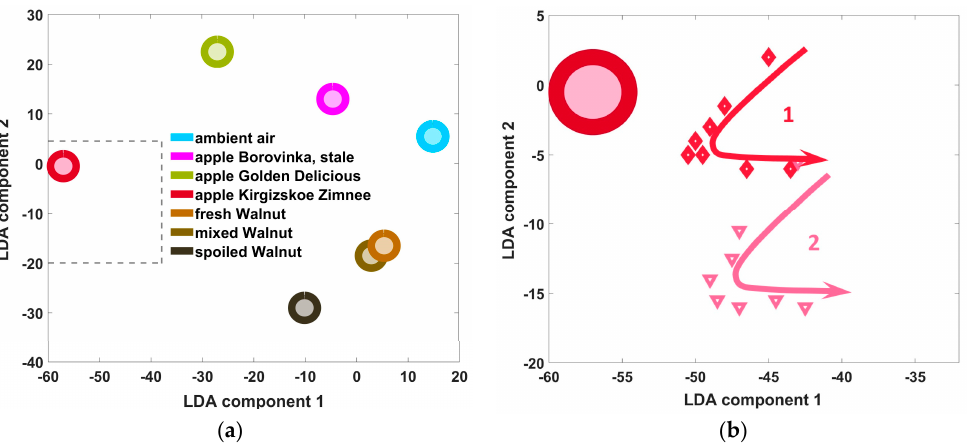
Figure 2. ( a ) General view of the class ellipses in LDA space illustrating the e-nose model built to recognize apples of different kinds (“Borovinka”, “Golden Delicious” and “Kirgizskoe Zimnee”) and walnuts (“Ak-Terek”) of different freshness; ( b ) Enlarged area framed in the plot (a) to draw e-nose data trajectories at the LDA space during exposures to Kirgizskoe Zimnee apple at the first (1) and second (2) rounds following LDA model building. The e-nose data of 2nd round are more than two times farther away from the training class position than these of 1st round.